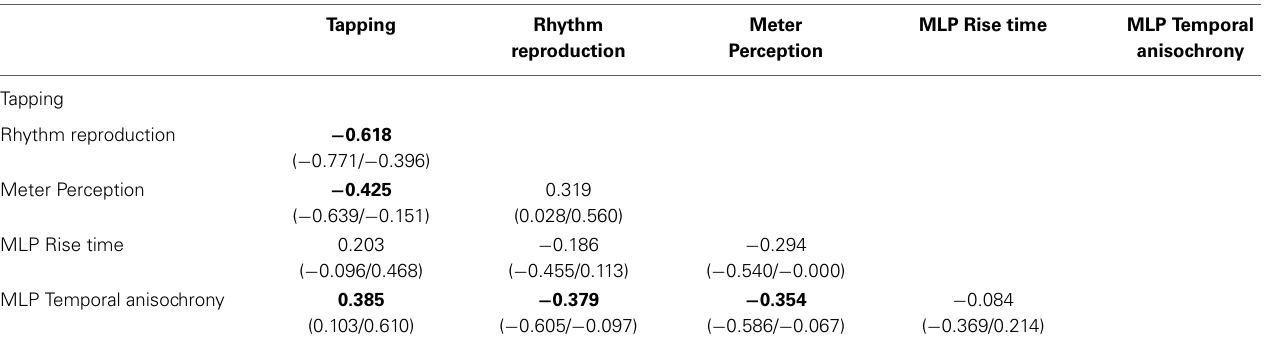
Table 3 | Spearman correlations between temporal processing tasks.